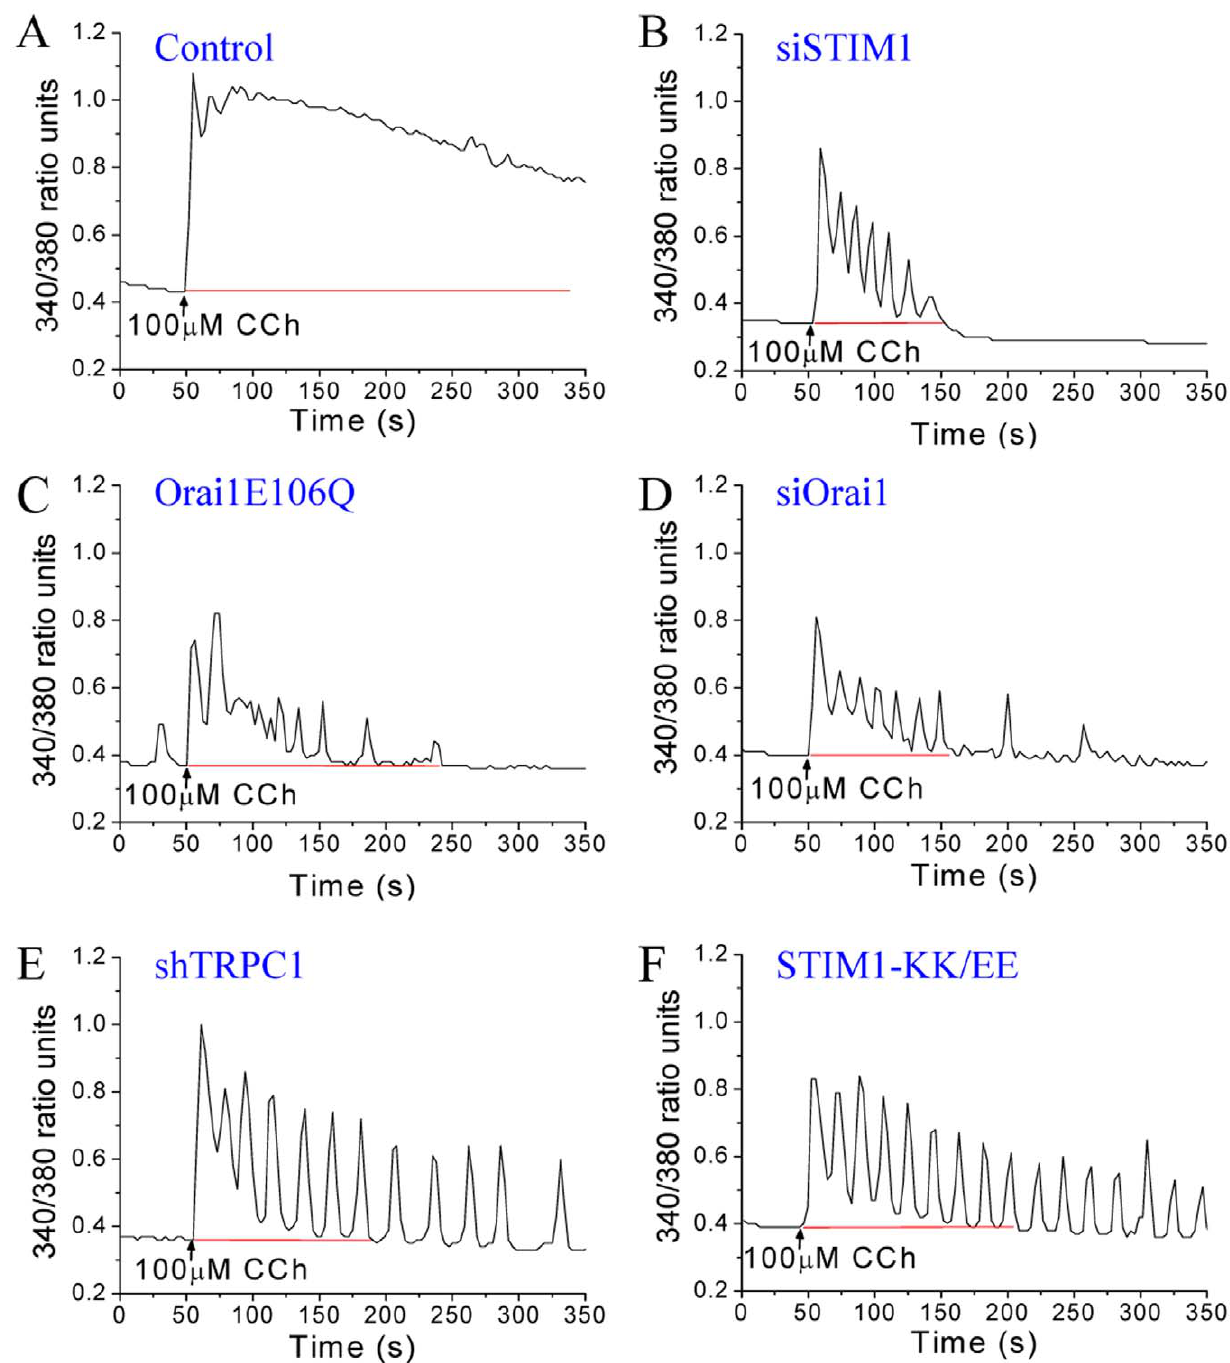
Figure 4. Contribution of Orai1 and TRPC1 to [Ca 2 + ] i signals in individual cells stimulated at high [CCh]. [Ca 2 + ] i increases induced by high [CCh] (100 m M) in control cells ( A ), and in cells transfected with siSTIM1 ( B ), Orai1E106Q ( C ), siOrai1 ( D ), shTRPC1 ( E ), or STIM1-KK/EE ( F ). Traces are from a single experiment and are representative of $ 50 cells in at least 3 separate experiments.